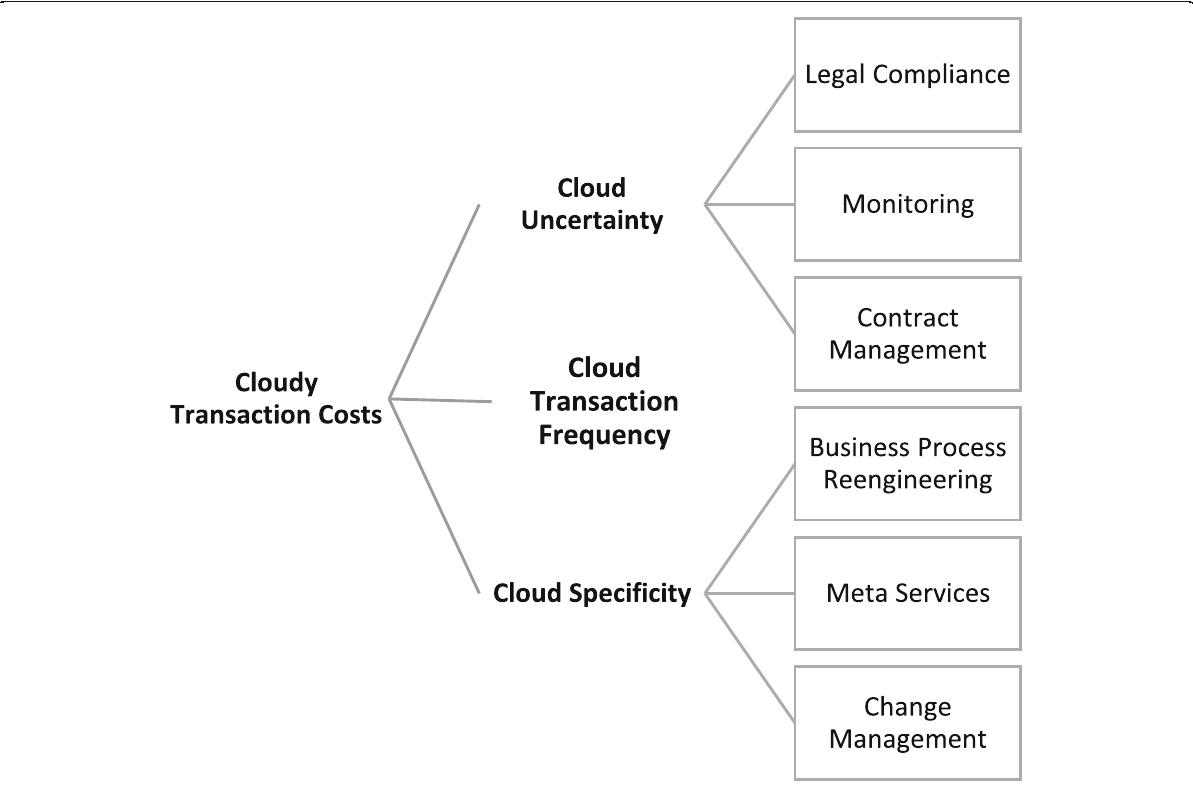
Fig. 1 Cost areas based on cloud transaction